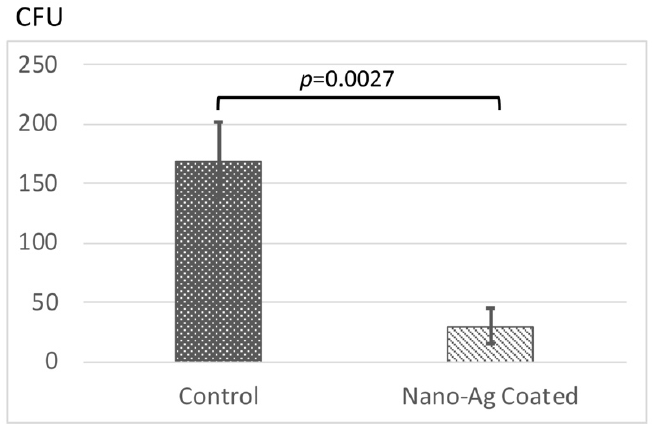
Figure 6. Antibacterial test according to ISO 22196: 2007(E). Error bars represent mean ± standard deviation for n = 3. The one-way analysis of variance and t -test comparisons were used for parametric analyses. Nano-Ag-coated surfaces significantly suppressed the colony-forming units (CFUs) compared to the control.